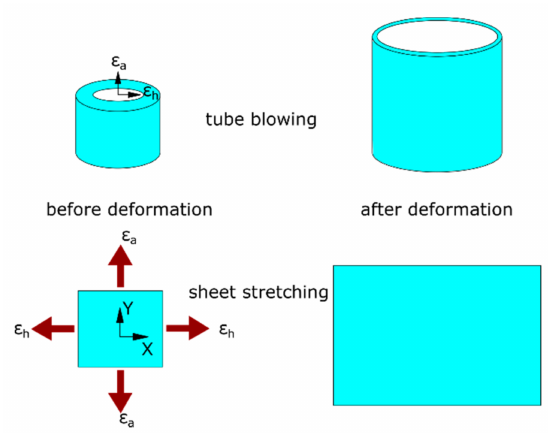
Figure 1. Replicative biaxial strain application ( top : tube blowing; bottom : sheet